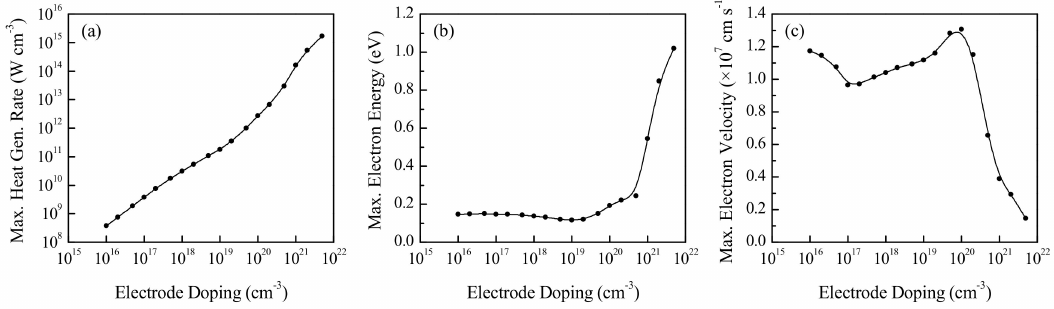
Figure 10. E ff ect of electrode doping on the maximum ( a ) volumetric heat generation rate, ( b ) electron energy and ( c ) electron drift velocity in a 10 nm channel n + nn +